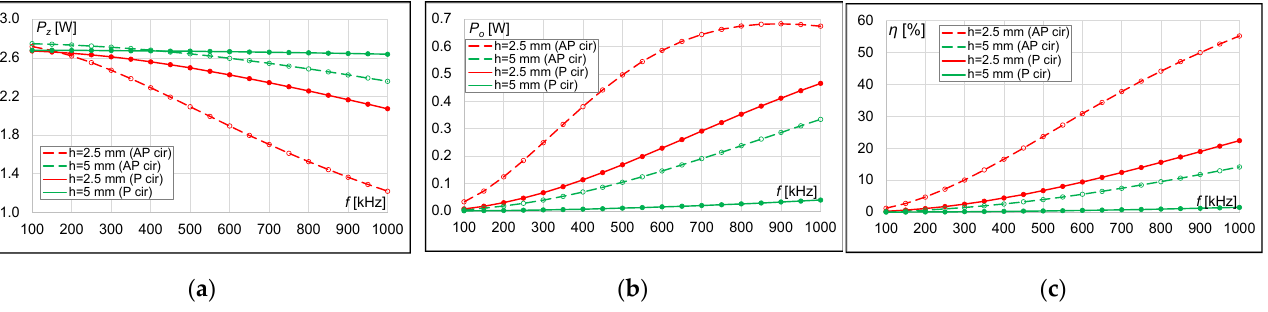
Figure 6. Results for circular coils with r = 5 mm and the number of turns n = 15 at two distances ( h = 2.5 mm and h = 5 mm): ( a ) transmitter power, ( b ) receiver power, ( c ) power transfer efficiency.